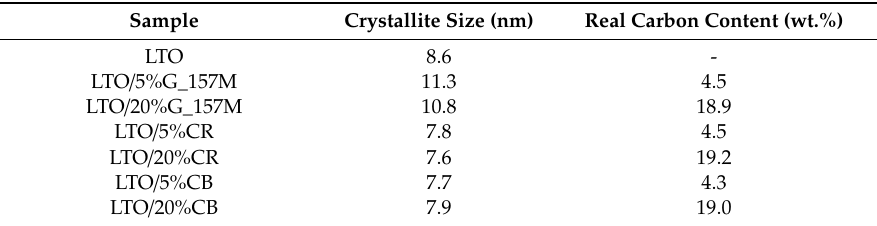
Table 1. The crystallite size (coherent scattering region) of Li 4 Ti 5 O 12 (nm) and the real carbon content for the obtained